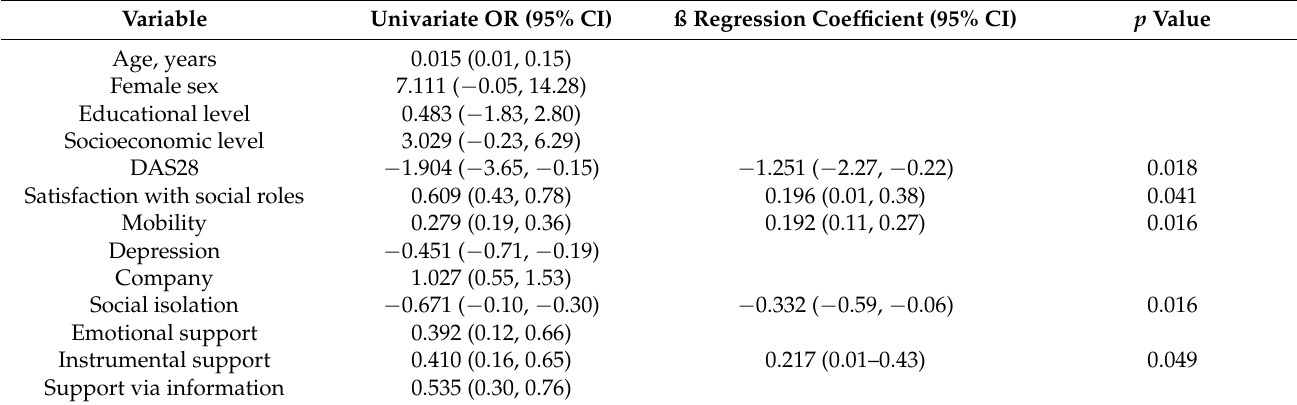
Table 4. Multivariable linear regression analysis of the characteristics associated with ability to participate in social activities in patients with rheumatoid arthritis.